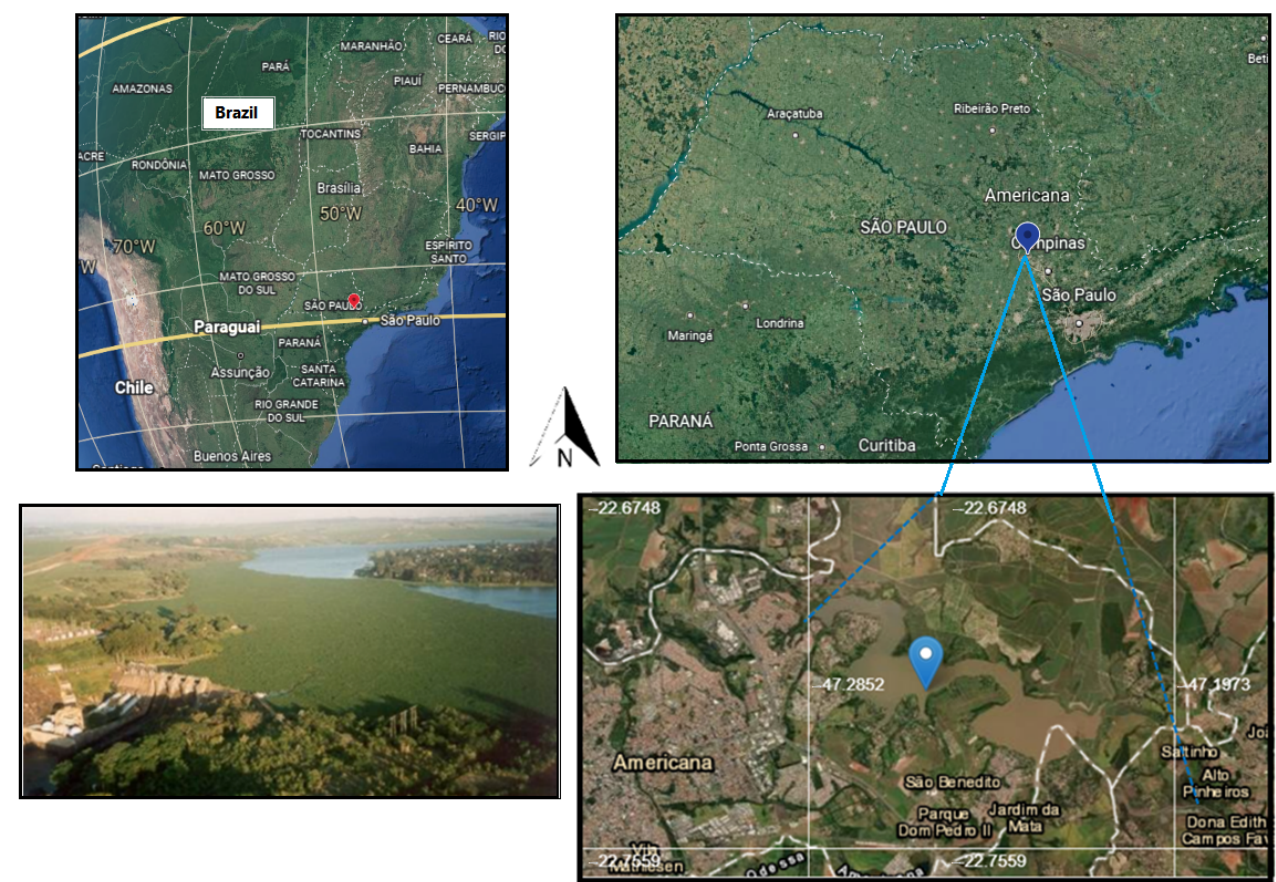
Figure 1. Salto Grande reservoir location in Brazil and São Paulo State (images at the top, from Google Earth). Position of the reservoir within the Americana municipality (image from Google Earth, at the bottom right), and an aerial image [25] of the dam highlighting the infestation by macrophytes (bottom left).